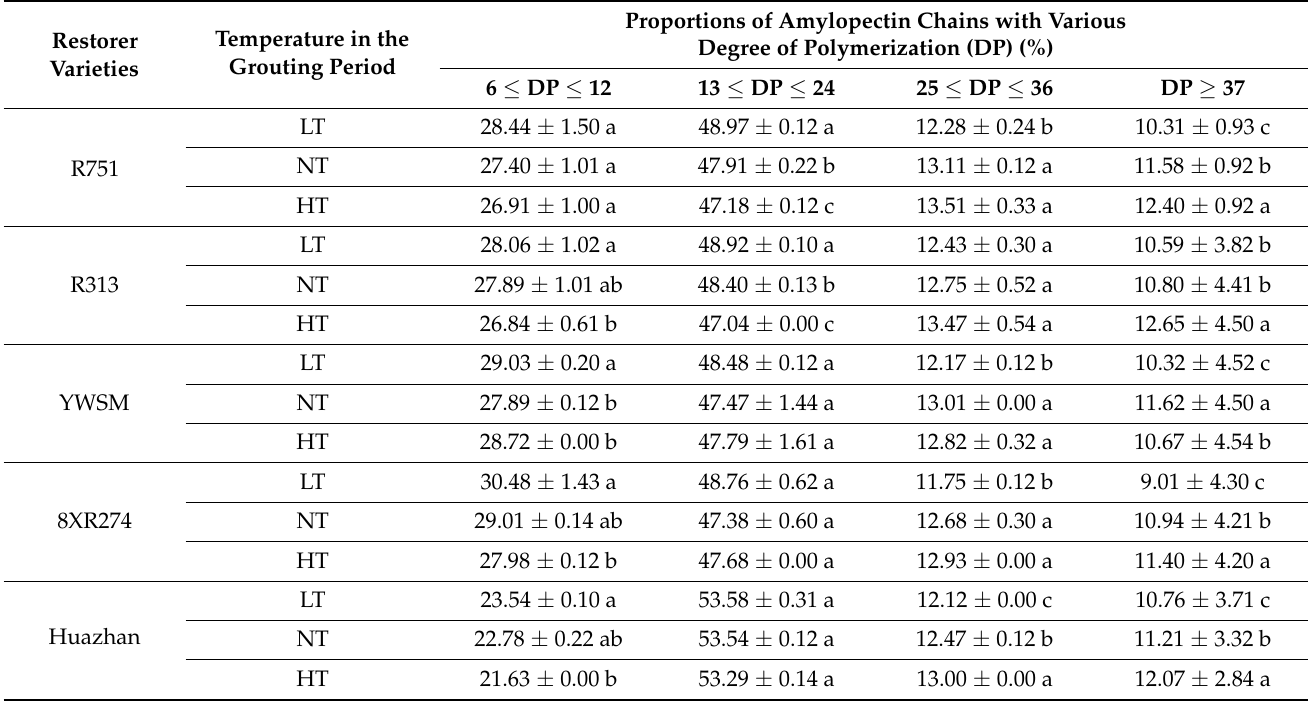
Table 2. Effect of suboptimal temperatures on the chain length distribution of